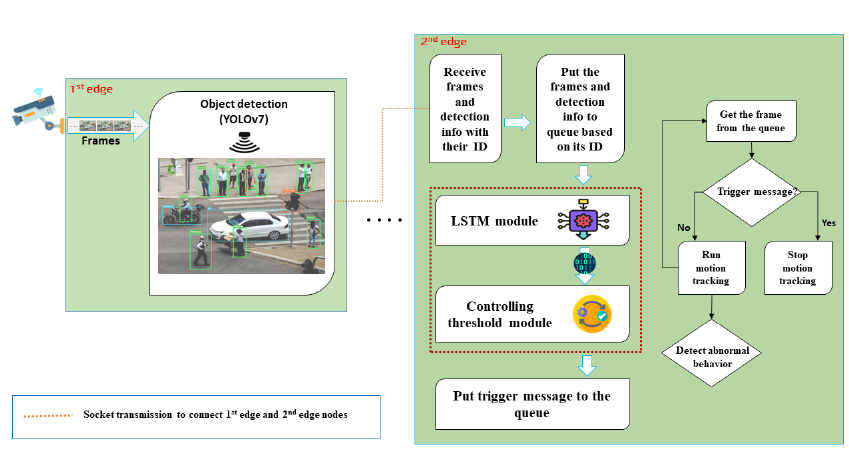
Figure 3. Overall architecture of the proposed